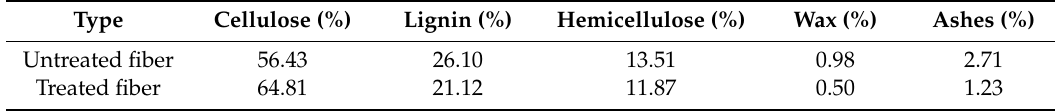
Table 3. Result of chemical characterization of the fiber.